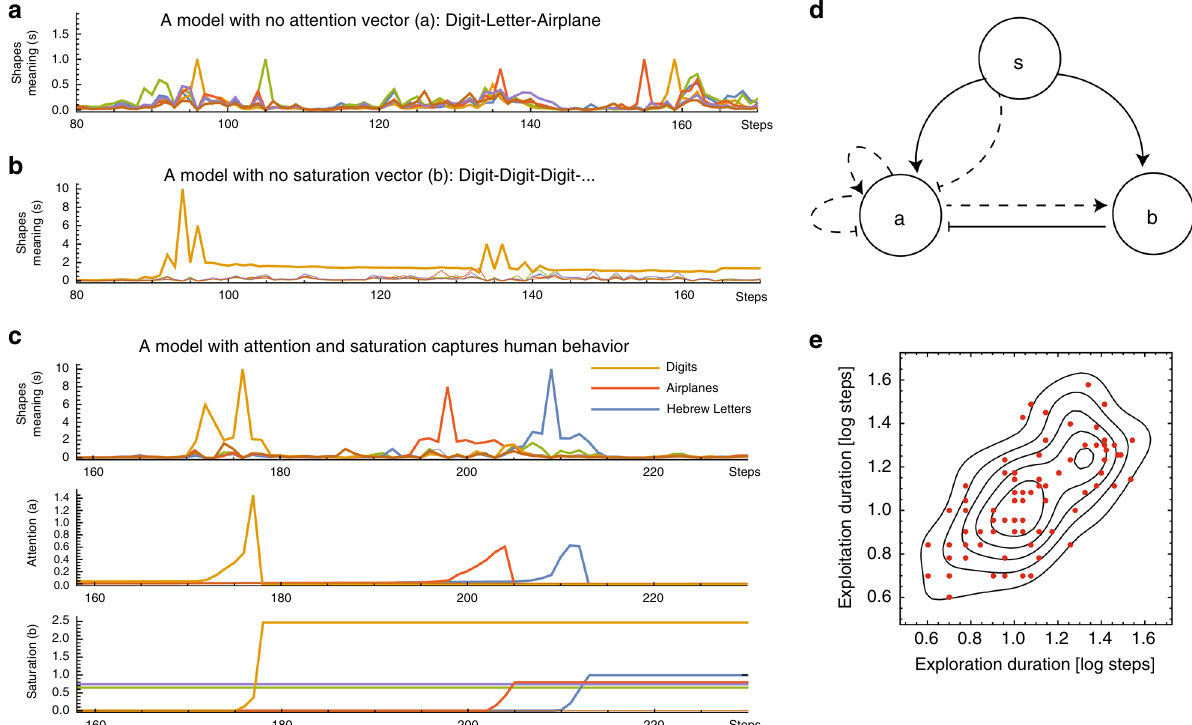
Fig. 4 Attention and saturation variables capture behavioral exploration-exploitation. a Search with no attention jumps between categories. b Search with no saturation is stuck at a single category. c Search with both attention and saturation variables can produce human-like search. a – c Line colors represent different meaning dimensions. d The general circuit for creative search — shapes with meanings induce attention in a speci fi c meaning dimension to grow, attention ( a ) can increase its own levels, inhibit attention in other meaning dimensions, and above a certain threshold attention levels increase saturation ( b ) which in turn, inhibits attention. Solid lines are obligatory connection of the circuit. Dashed lines mark possible connections between variables. e An FCD circuit (see Eqs. (5) and (6)) with different parameters (red dots) captures similar dynamics of the exploration-exploitation plane as the behavioral data (marked by lines of equal density of players ’ exploration-exploitation durations). The correlation of the simulated data is similar to the behavioral data (FCD: Spearman correlation, r = 0.71, p < 10 − 5 , Behavioral data: Spearman correlation, r = 0.73, p < 10 − 5